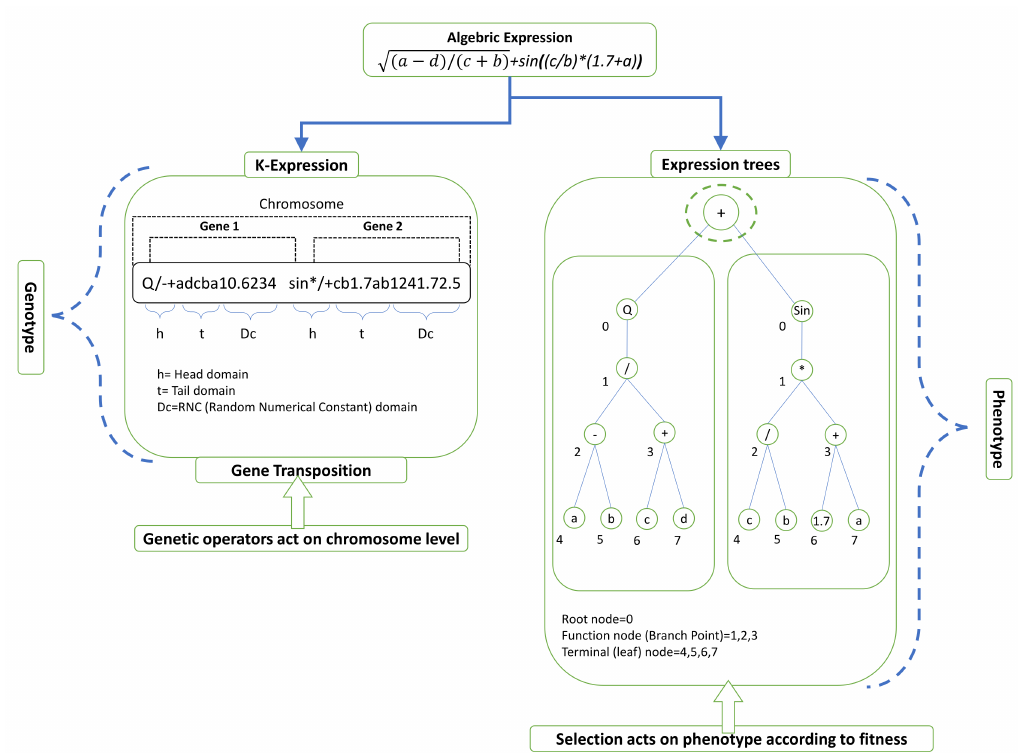
Figure 4. Illustration of a mathematical equation and its equivalent expression tree